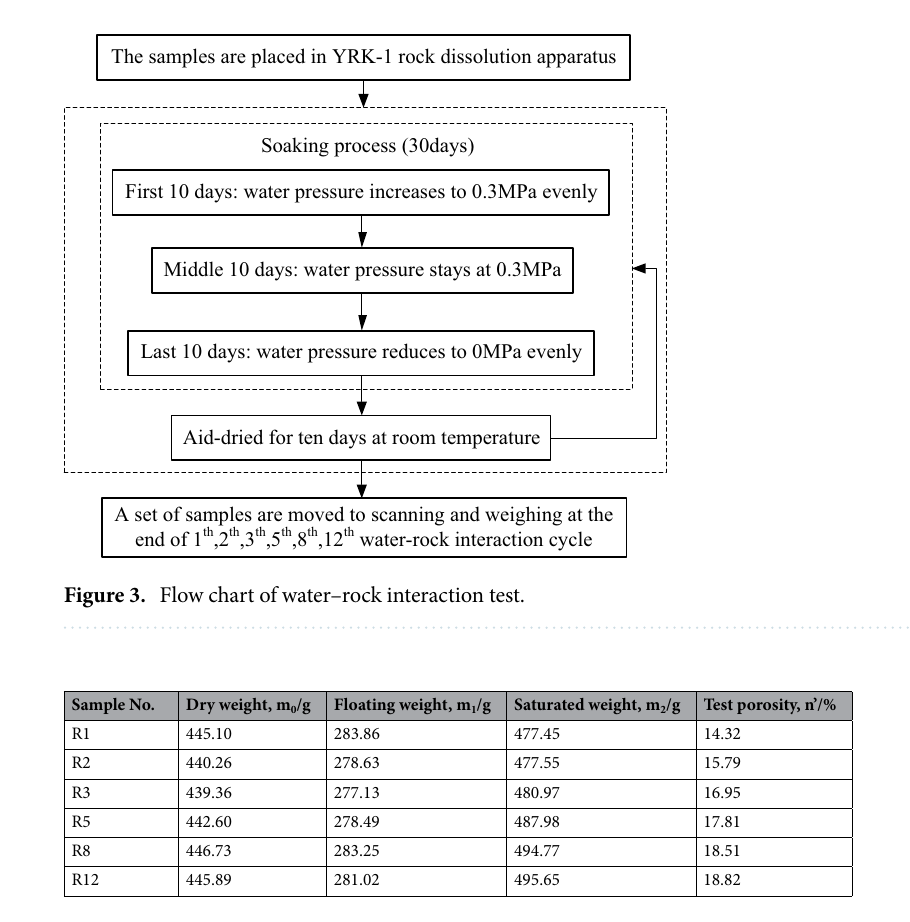
Table 1. Weights and test porosity of rock samples.